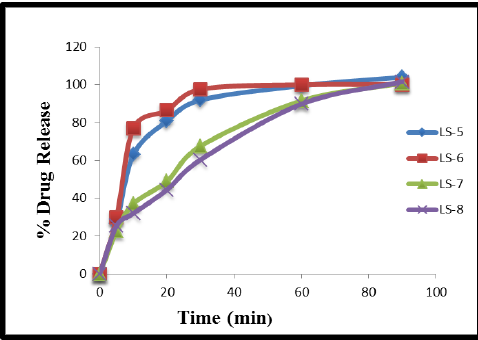
Figure 16. Dissolution profiles of clopidogrel from liquisolid compacts (LS 5 – 8) in phosphate buffer (pH 6.8) with 1% SLS at 37˚C